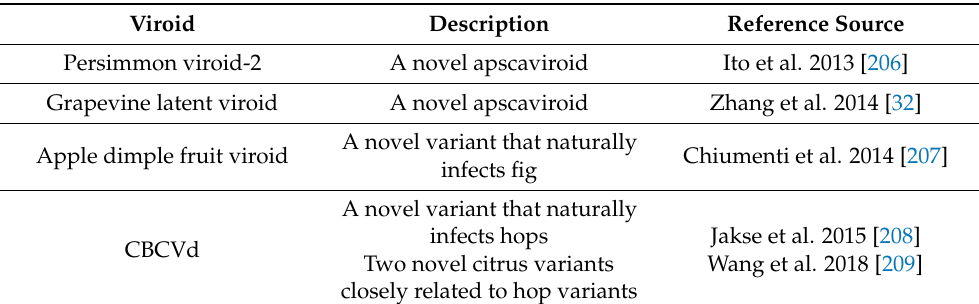
Table 4. Examples of novel viroids and variants discovered by next-generation sequencing (NGS) technologies. (Adapted from Hadidi, 2019) [12]. Viroid Description Reference Source Persimmon viroid-2 A novel apscaviroid Ito et al. 2013 [206] Grapevine latent viroid A novel apscaviroid Zhang et al. 2014 [32] A novel variant that naturally Apple dimple fruit viroid Chiumenti et al. 2014 [207] infects fig A novel variant that naturally infects hops Jakse et al. 2015 [208] CBCVd Two novel citrus variants Wang et al. 2018 closely related to hop variants